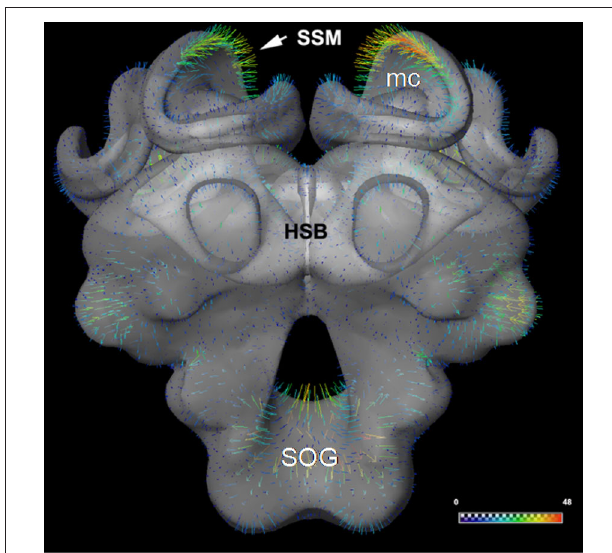
Figure 8 | A comparison of the iterative average shape brain (HSB) and the statistical shape model (SSM). The mean surface distance measured after rigid registration of HSB onto the SSM amounts to 8.5 μm. Only the surface model of the HSB is shown here, and the surface distances between HSB and SSM are indicated by colored vectors (arrow and false-color scale bar). Note the particularly large distance at the median calyx (MC) and subesophageal ganglion (SOG), which might be due to the stronger shrinkage process caused by the different histological procedures employed for the two models (see section “Methods” and